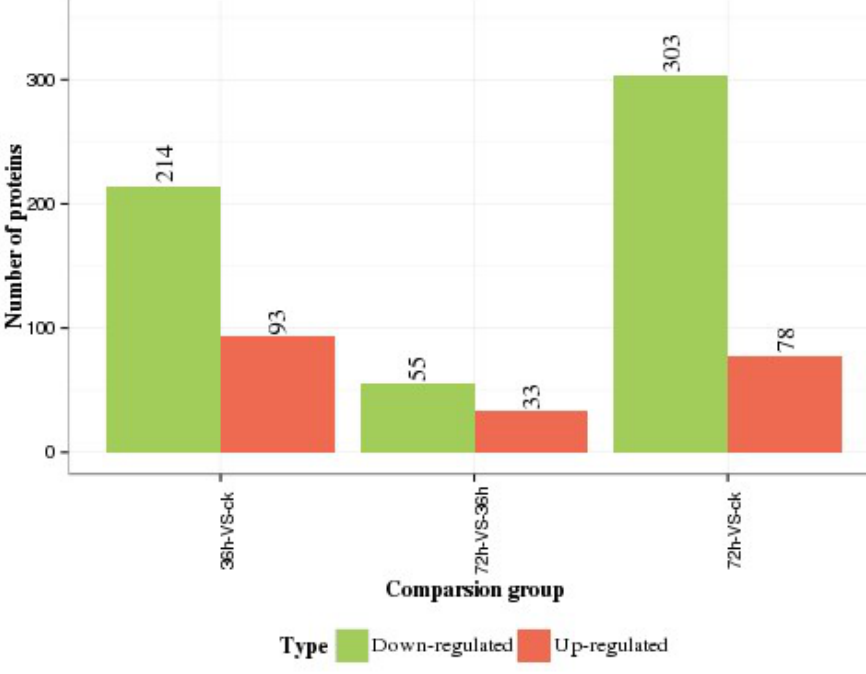
Figure 4. Numbers of differentially expressed proteins in hemocytes.